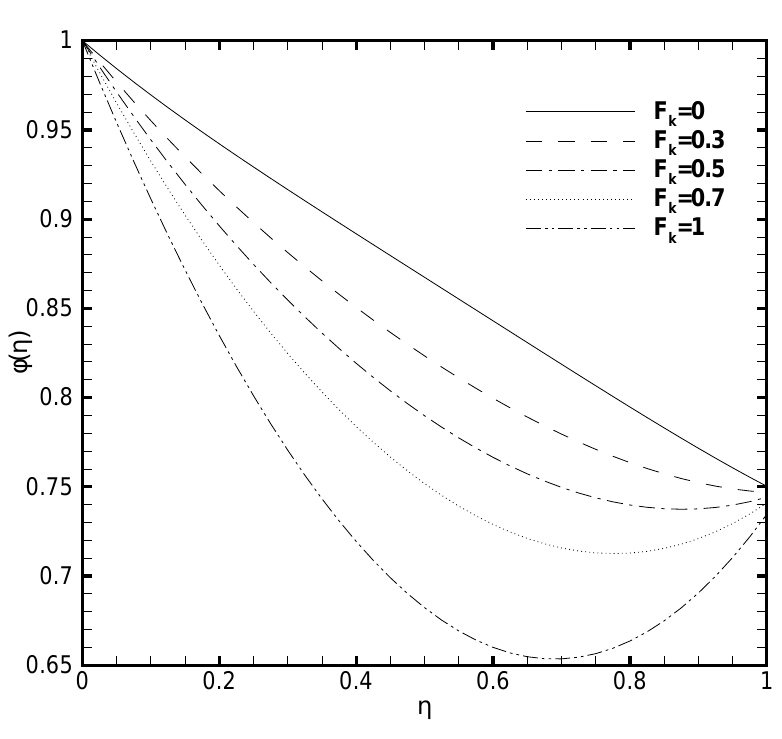
Figure 8. Nanoparticles concentration profile φ ( η ) for several values of Frank-Kamenetskii number F k when ζ = P = κ = Ha = Br = δ θ 2 = 1, N b = 0.2, N t = 0.1, β = 0.05 and δ θ 1 =